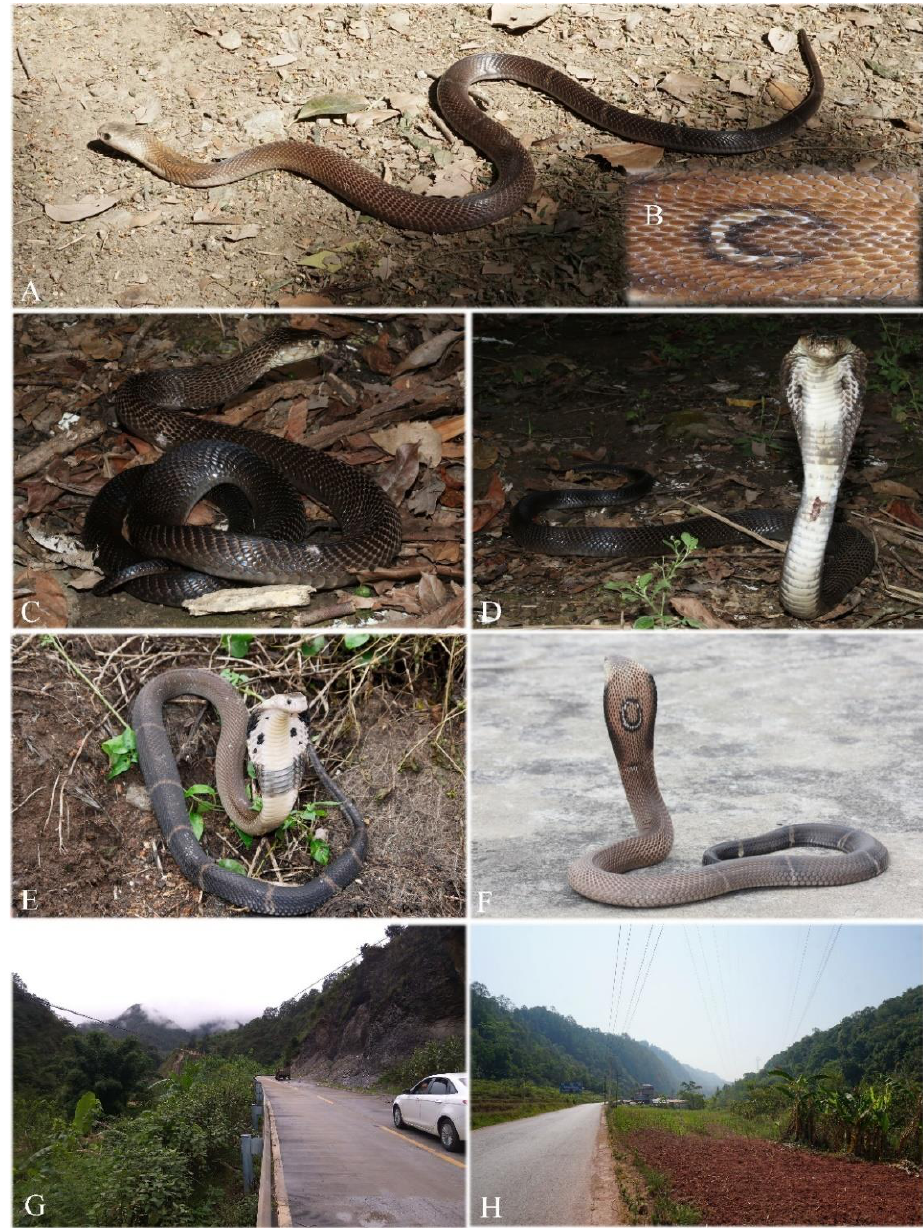
Figure 10. Naja fuxi sp. nov. in life and habitats. ( A , B ) Dorsolateral view and hood pattern of adult female paratype CIB DL2018081005 from Panzhihua, Sichuan, China; ( C , D ) Dorsolateral and front view of an unvouchered adult from Jiangcheng, Pu’er, Yunnan, China; ( E , F ), two adults from Wenshan, Yunnan, China; ( G ) Subtropical Forest at type locality Panzhihua, Sichuan, China; ( H ) Tropical monsoon forest and farmland at Jiangcheng, Pu’er, Yunnan, China. (Photos ( A , B , H ) by Sheng-Chao Shi; ( C , D , G ) by Li Ding; ( E , F ) by Liang Zhang). Holotype. Adult male CIB DL2018053147 (Figure 4D), collected from Tongde Town, Renhe District, Panzhihua City, Sichuan Province, China (26.710278° N ， type is a roadkill but was only barely damaged.